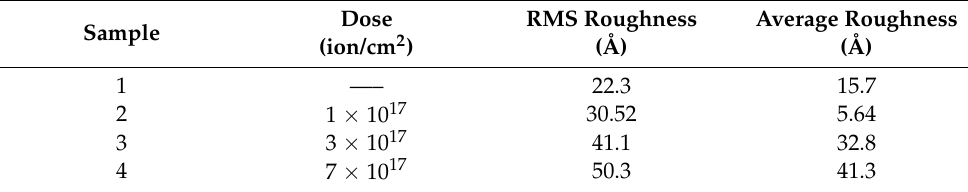
Table 3. The values of average roughness and root mean square roughness of samples.